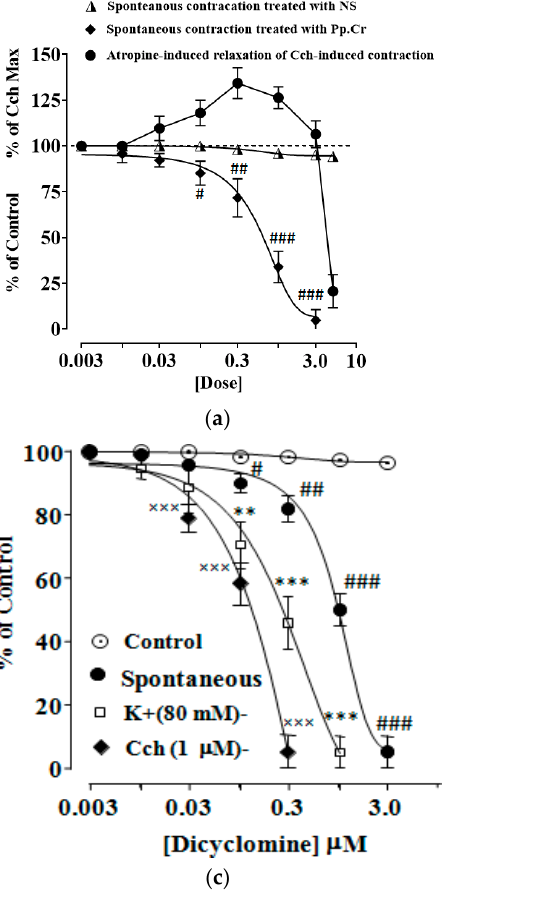
Figure 2. Concentration-dependent inhibitory effect of atropine (0.3 and 1.0 µM) and Pp.Cr (mg/mL) on Cch-induced contracting isolated rabbit jejunum preparations and spontaneously contracting rabbit jejunum preparations respectively ( a ). Concentration-dependent inhibitory effect of Pp.Cr (mg/mL) ( b ), dicyclomine (µM) ( c ) and dantrolene (µM) ( d ) against spontaneously contracting rabbit jejunum preparations, K + (80 mM)- and Cch (1 µM)-induced jejunum contractions. # p < 0.05; ## p < 0.01; ### p < 0.001 compares the effects of various conc. of Pp.Cr (mg/mL) on spontaneous jejunum contractions. * p < 0.05; ** p < 0.01; *** p < 0.001 compares the effects of various conc. of Pp.Cr (mg/mL) on K + (80 mM)-induced jejunum contractions. × p < 0.05; ×× p < 0.01; ××× p < 0.001 compares the effects of various conc. of Pp.Cr (mg/mL) on Cch (1 µM)-induced jejunum contractions. (Mean ± SEM, n = 5).